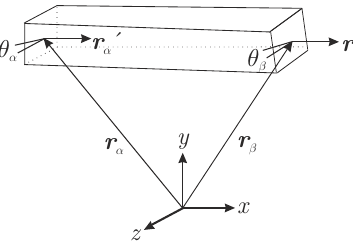
Figure 3. Degrees of freedom for one beam finite element in the nodes α and β : axial position vector r , slope vector r 0 , and cross section orientation angle θ